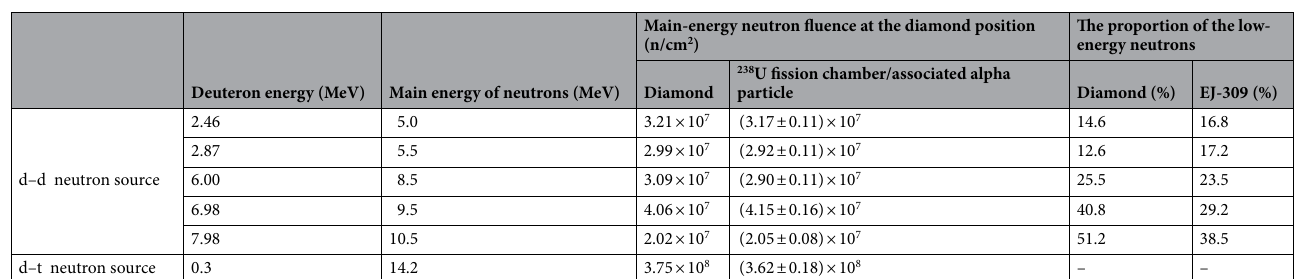
Table 2. The comparation of the main-energy neutron fluences at the diamond position measured using the diamond detector and fission chamber/associated alpha particle method, and the comparation of the proportions of the low-energy neutrons measured with the diamond detector and the EJ-309 liquid scintillator.